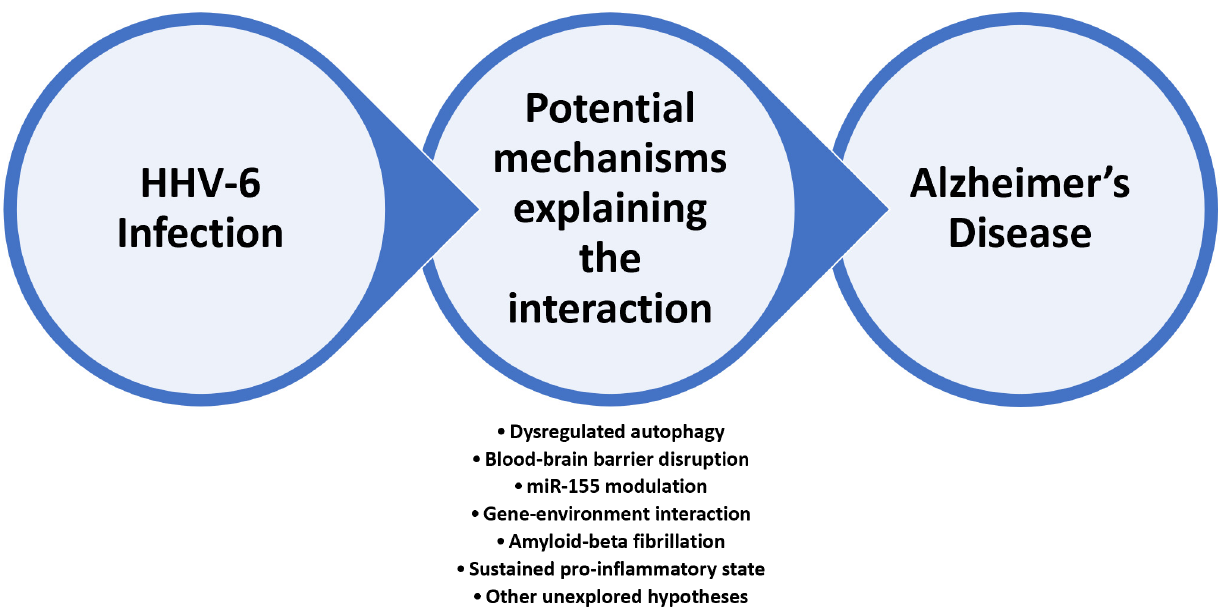
Figure 1. A summary of the mechanisms involved in the interaction between HHV-6 and Alzheimer’s disease.